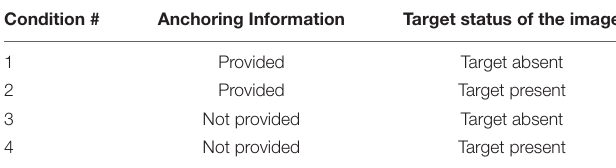
TABLE 3 | Experimental conditions in Experiment